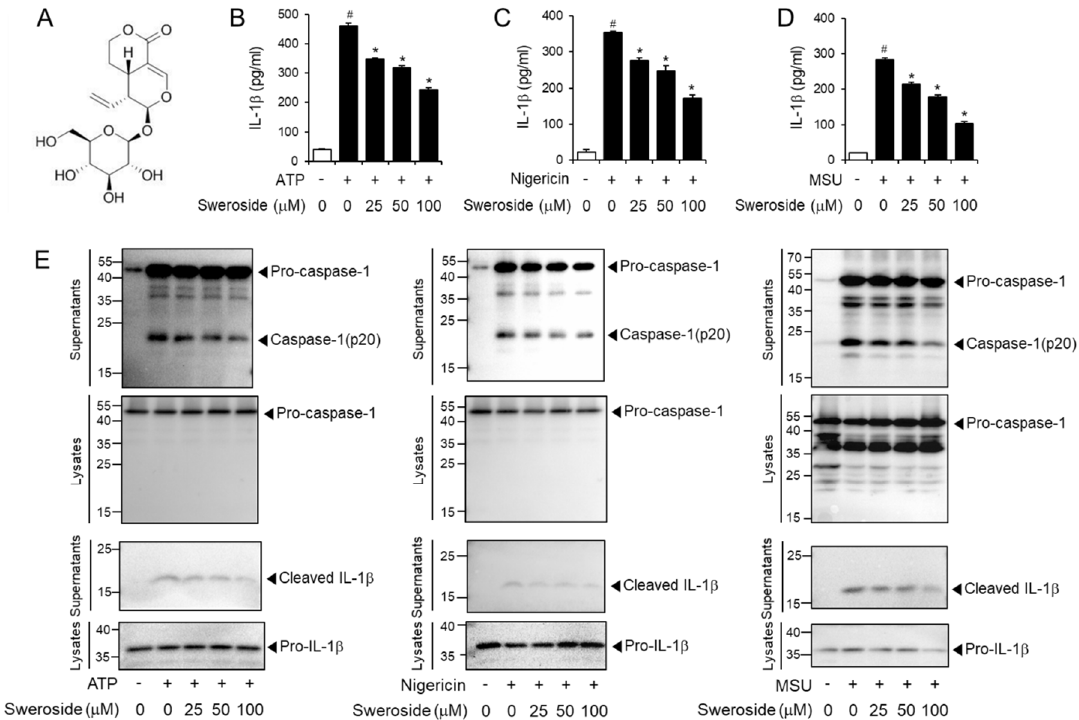
Figure 1. Sweroside inhibits the activation of the NLRP3 inflammasome in primary macrophages. ( A ) Chemical structure of sweroside. ( B – D ) Bone marrow-derived macrophages (BMDMs) were primed with LPS (100 ng / mL) for 4 h. The cells were treated with sweroside for 1 h and then stimulated with ( B ) ATP (5 mM) for 2 h, ( C ) nigericin (10 µ M) for 16 h, or ( D ) MSU (500 µ g / mL) for 6 h. Cell culture supernatants were analyzed for secreted IL-1 β by ELISA. The values represent the means ± SEM ( n = 3). #, significantly di ff erent from vehicle alone, p < 0.05. *, significantly di ff erent from ATP, nigericin, or MSU alone, p < 0.05. ( E ) BMDMs were primed with LPS (100 ng / mL) for 4 h. The cells were treated with sweroside for 1 h and then stimulated with ATP (5 mM) for 1 h, nigericin (10 µ M) for 1 h, or MSU (500 µ g / mL) for 4.5 h. The cell culture supernatants and cell lysates were immunoblotted for pro-caspase-1, caspase-1(p20), pro-IL-1 β , and IL-1 β